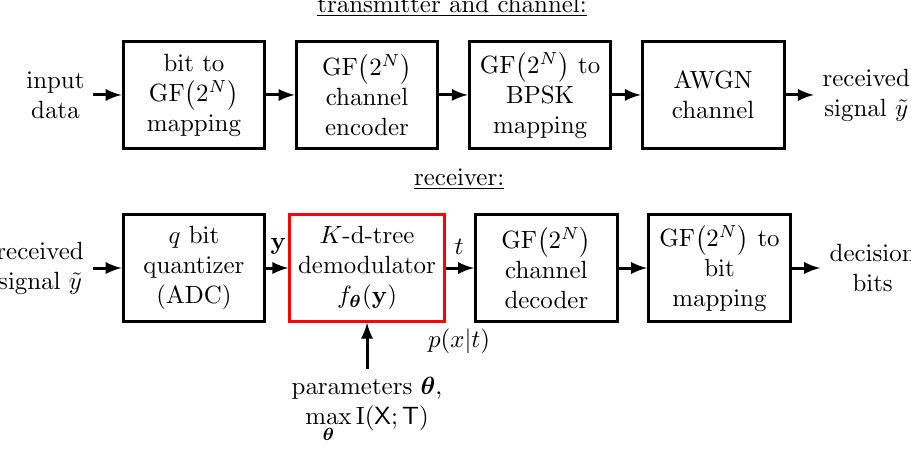
Figure 9. Illustration of the considered data transmission scheme which employs a non-binary low- density parity-check code over GF 2 N . At the receiver, a demodulator using the nearest neighbor search from Section 3.1.2 in K -dimensional trees is (cid:0) (cid:1)